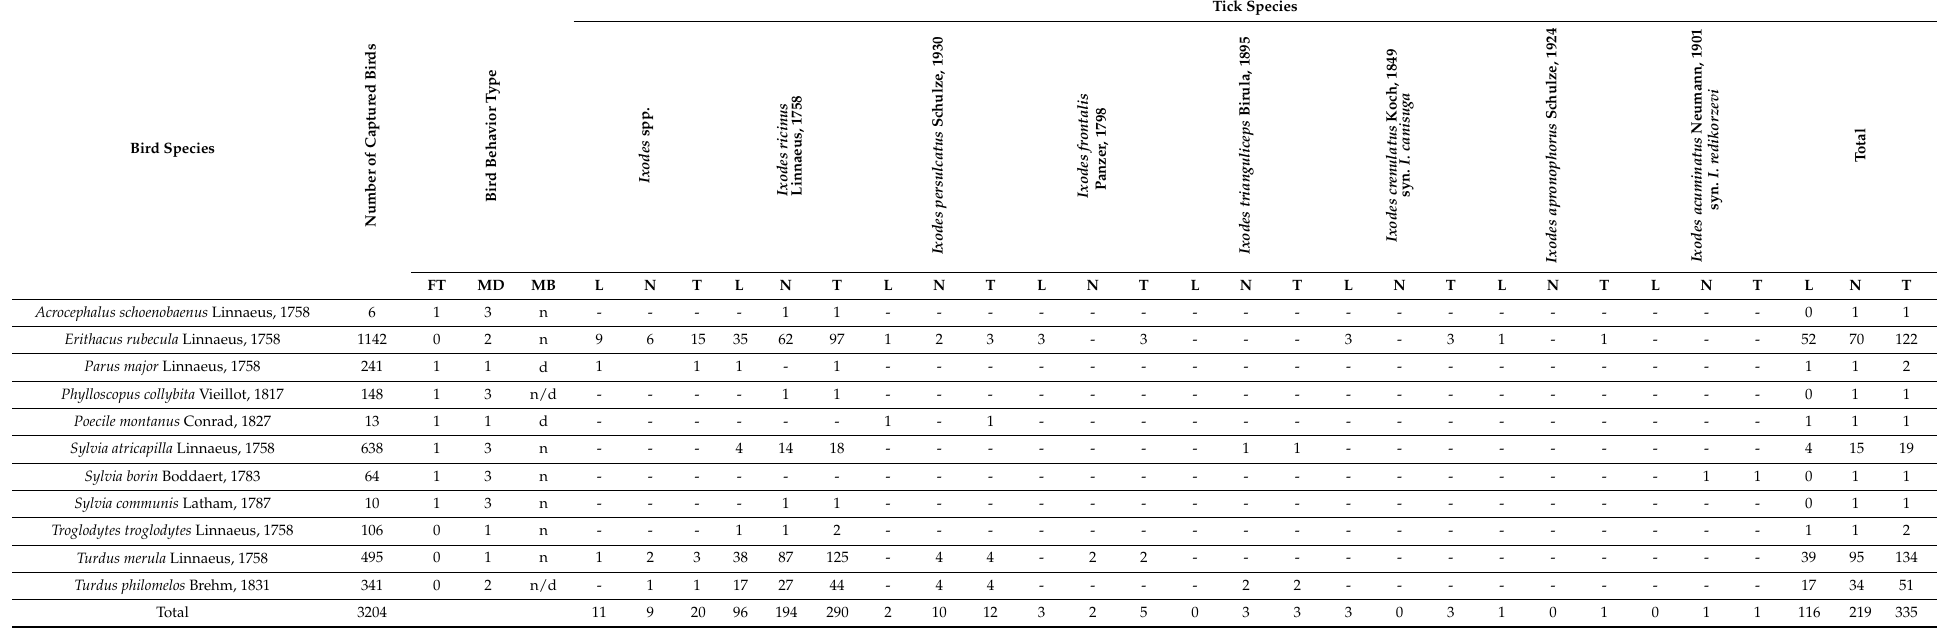
Table 2. Ticks infesting birds and bird behavior